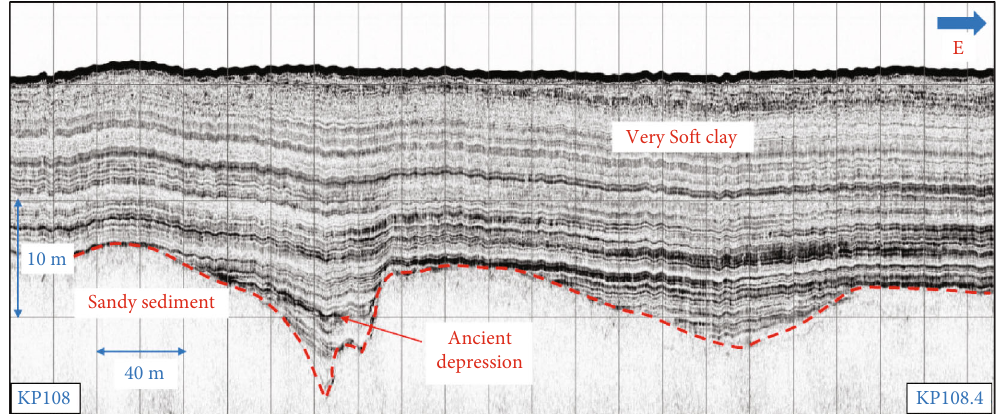
Figure 12: Shallow stratigraphic images of a typical erosion depression geomorphic